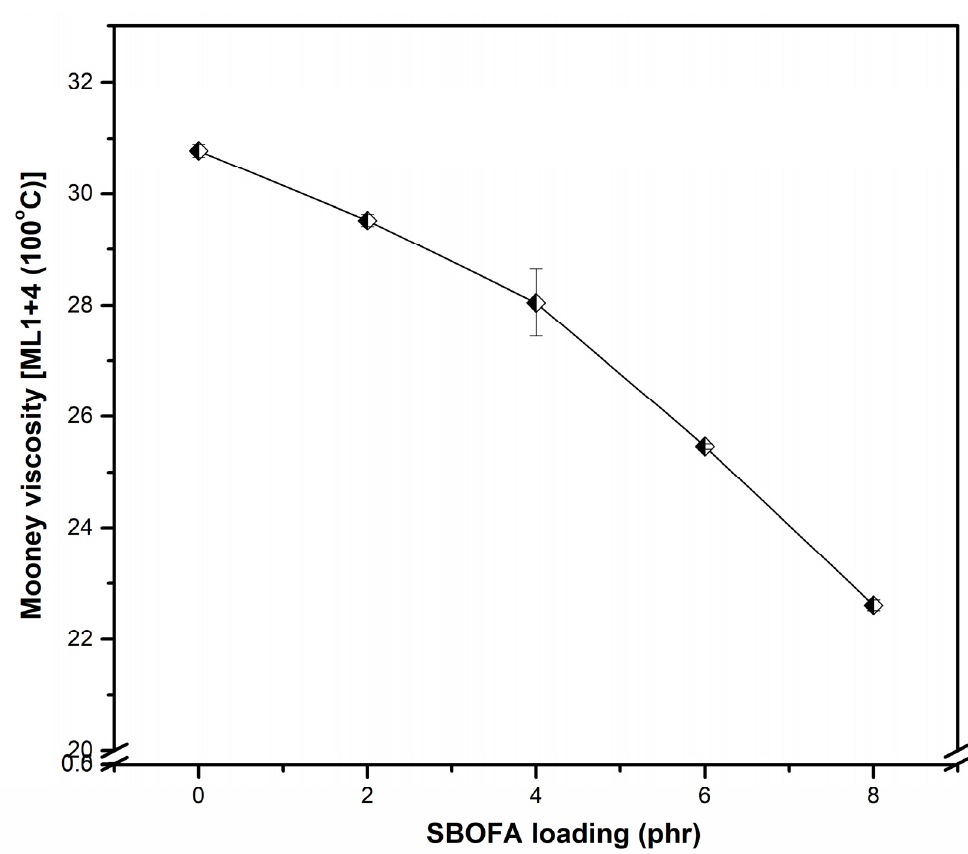
Figure 3. Mooney viscosity of NBR compounds with varying SBOFA loadings. Data are shown as the mean ± 1SD, derived from three experiments.